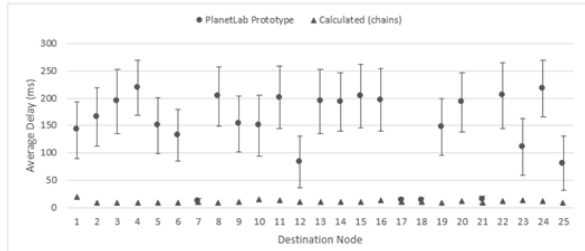
Fig. 13. Average Delay for Multicast Network with 50 Nodes and 25 Destinations